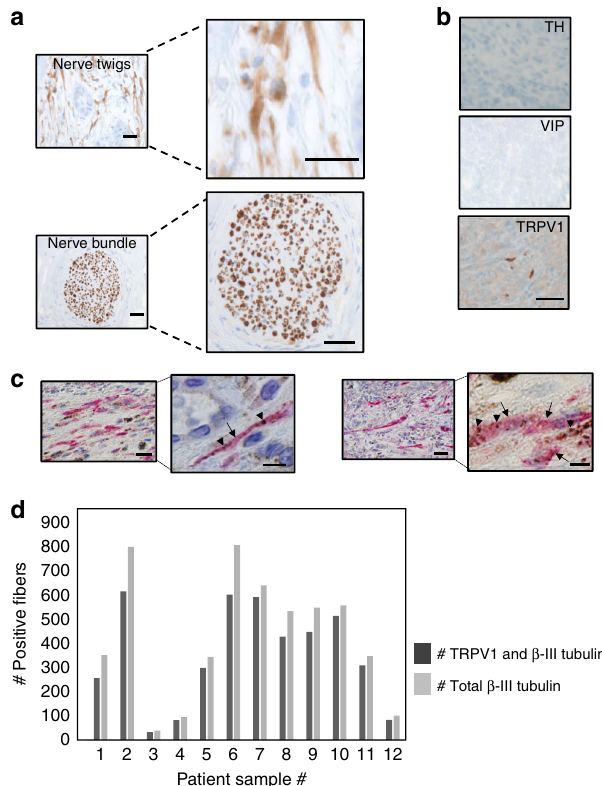
Fig. 1 Sensory nerves innervate head and neck squamous cell carcinomas. a En face bright fi eld images of HNSCC nerve “ twigs ” and “ bundle ” IHC stained for β -III tubulin ( n = 30 patient tumors analyzed) (scale bars, 50 µ m); brown, immunostain; blue, counterstain; b En face bright fi eld images of HNSCC IHC stained for Tyrosine Hydroxylase (TH), Vasoactive Intestinal Polypeptide (VIP) and Transient Receptor Potential